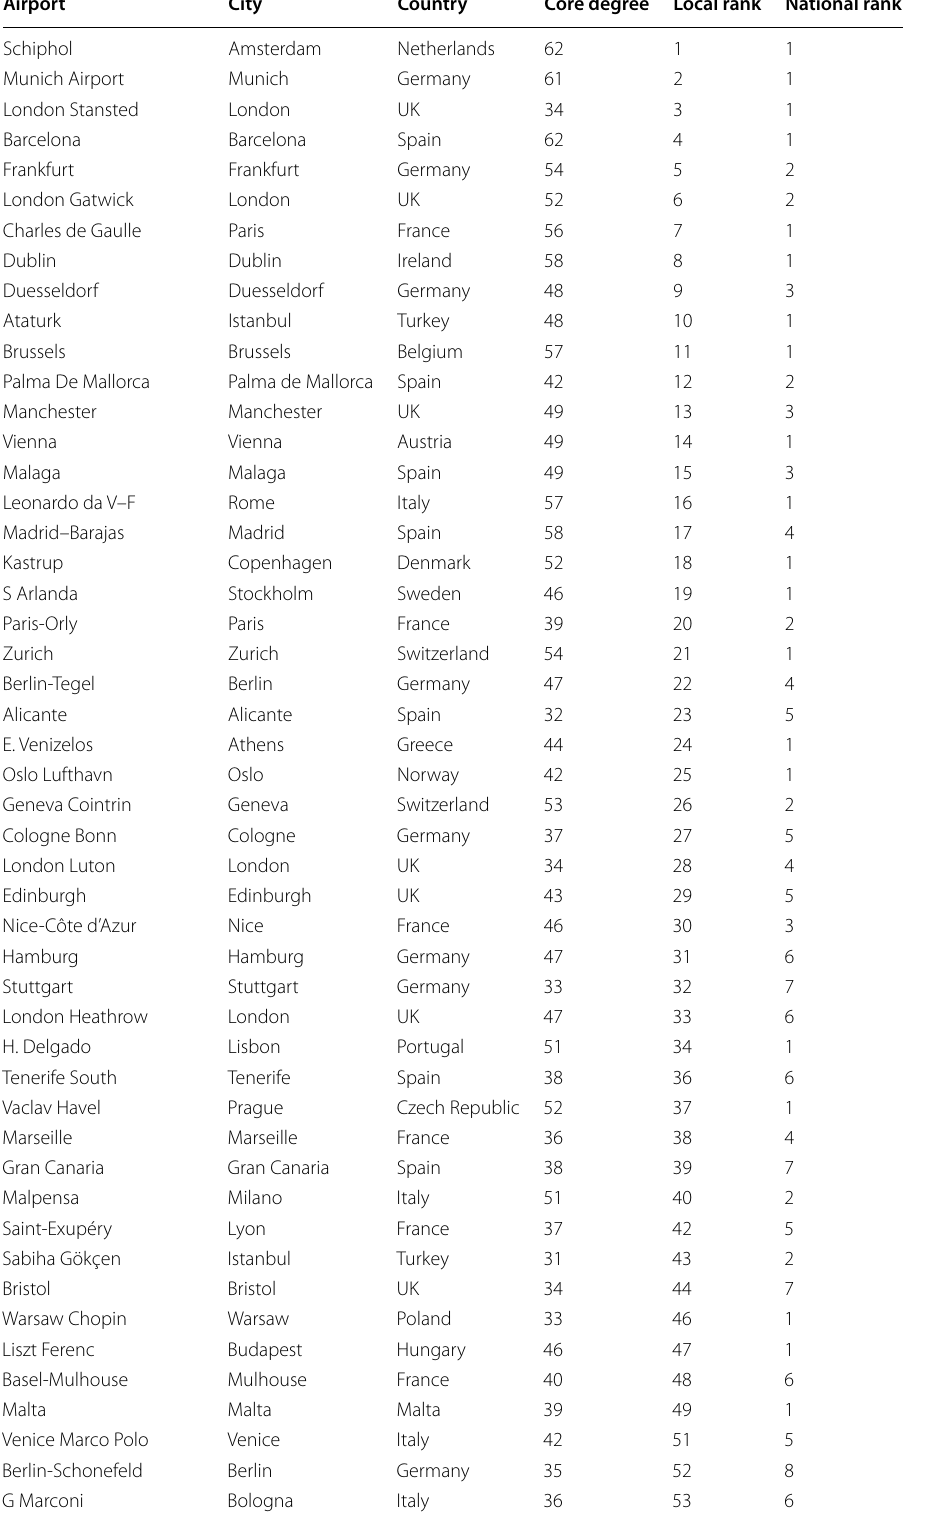
Table 11 Core airports of the European component (65)